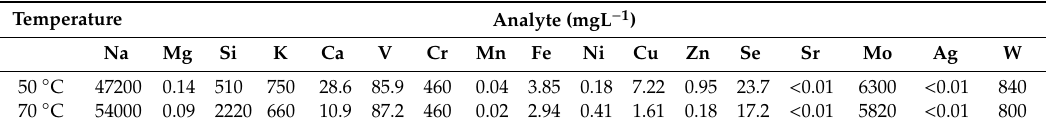
Table 2. Chemical composition of the extracts of hydrometallurgical treatment (3 d, 1.5 M NaOH, L:S ratio 15:1) of the abrasion product of sample